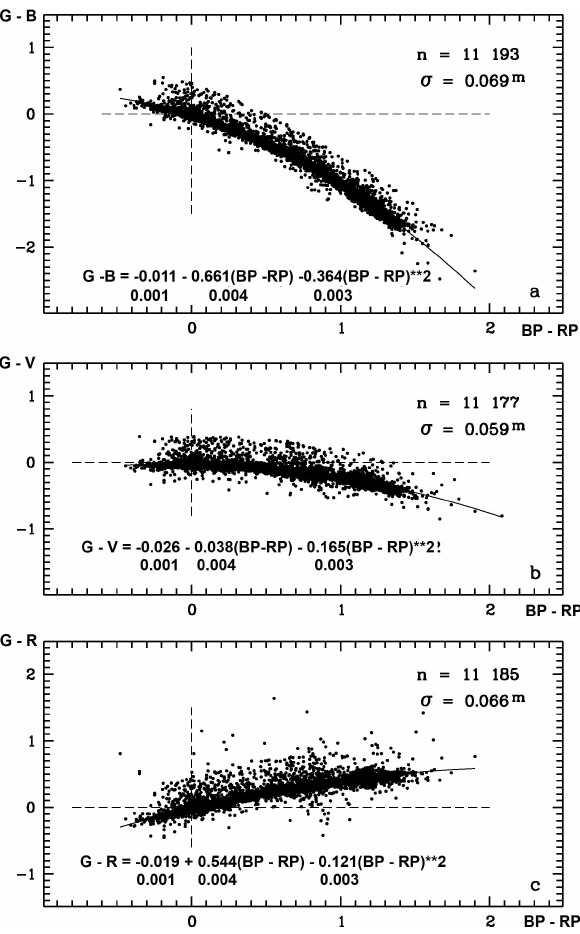
Figure 11. Relationship between the B, V, R Johnson photoelectric stellar magnitudes and the BP, G, RP GAIA DR2 stellar magnitudes.